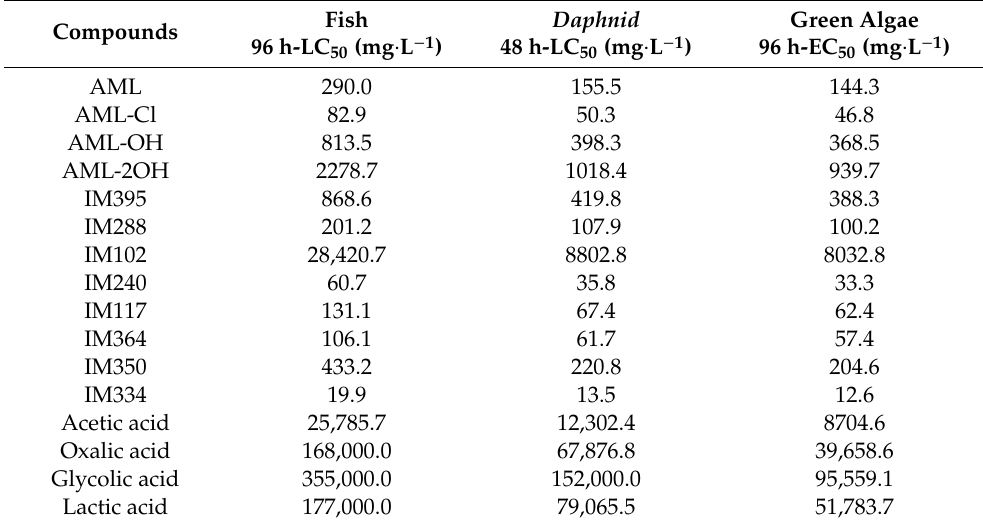
Table 4. Estimated acute toxicity of AML and its intermediates by ECOSAR software.